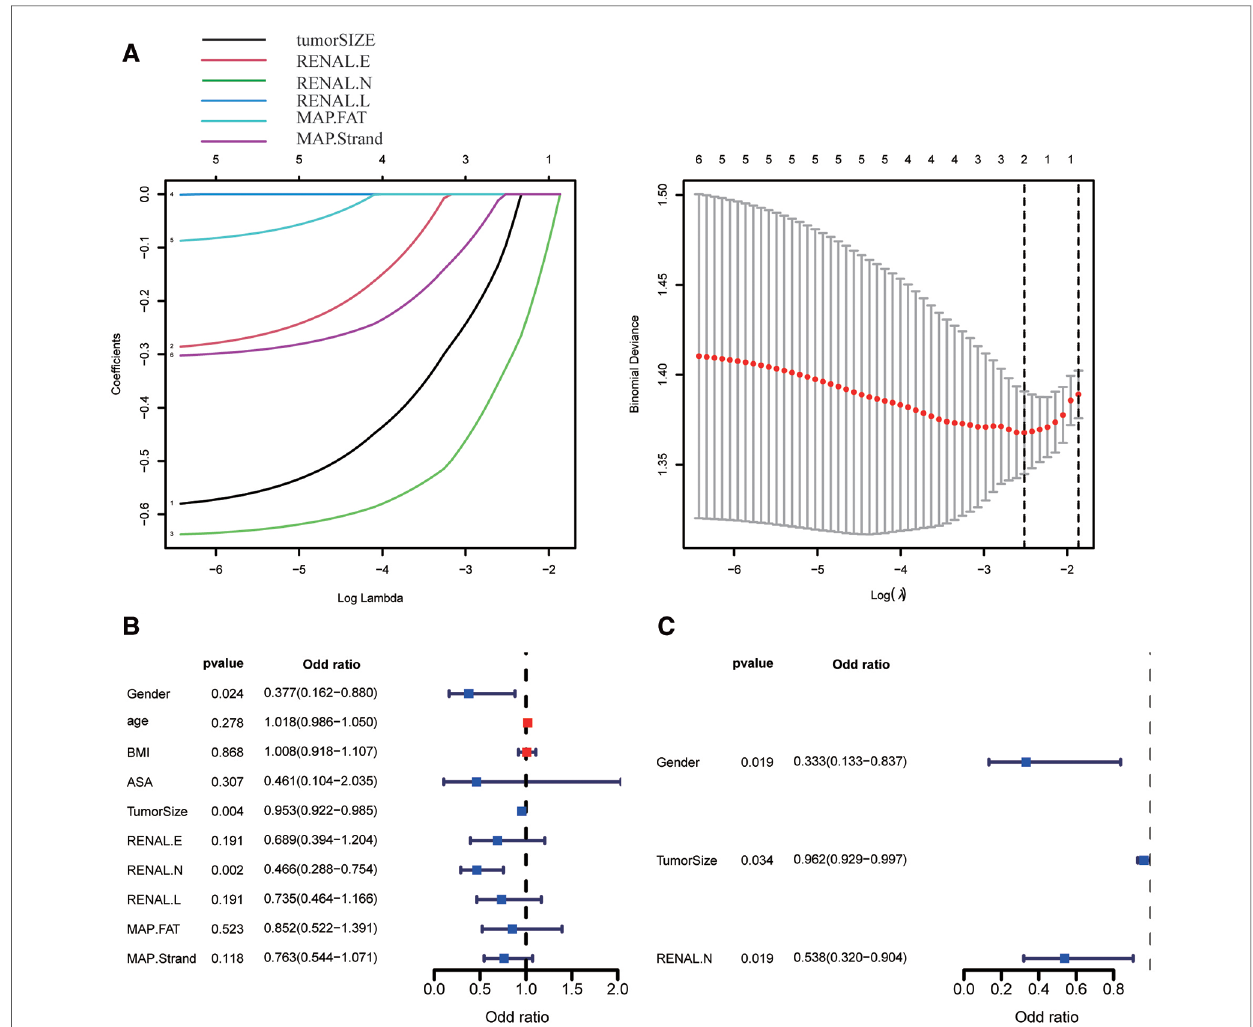
FIGURE 6 Screening the key factors of clinical variables and scoring elements in predicting whether to obtain trifecta by using lasso regression ( A ), univariate ( B ) and multivariate regression analysis ( C ). (In Figure 6A , 1 – 6 are tumorSIZE, RENAL.E, RENAL.N, RENAL.L, MAP.FAT, and MAP.Strand,